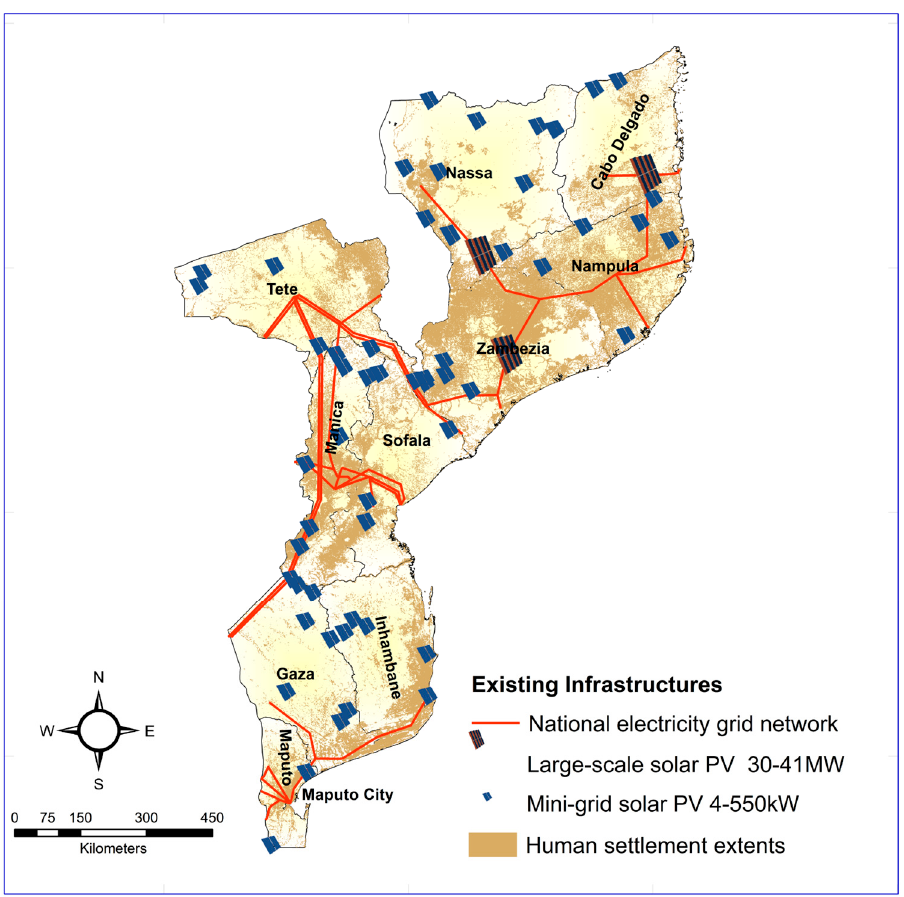
Figure 5. Existing energy infrastructure in Mozambique (solar power stations and existing network) and human settlement extents.